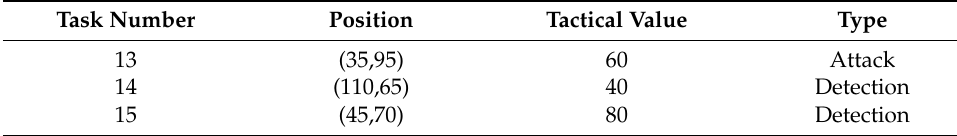
Table 8. New task parameters.